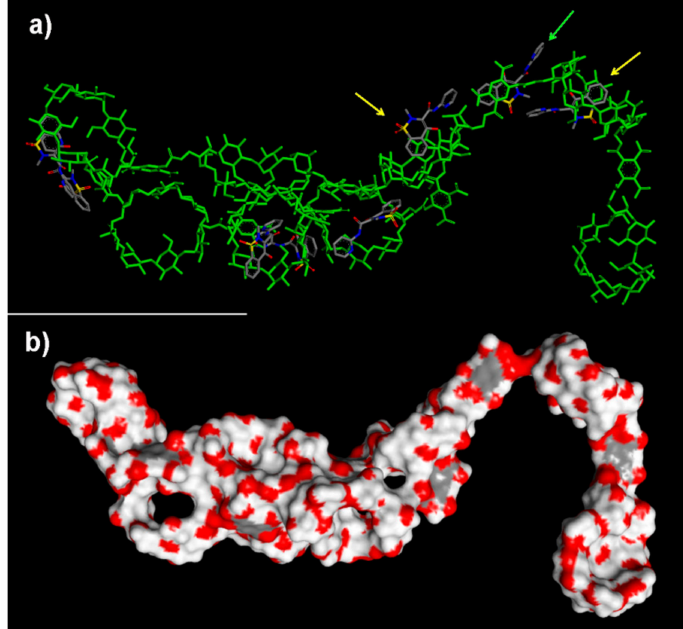
Figure 8. In the Figure, panel ( a ) shows the optimized geometry assumed by the NS / 8 PX drug molecules system at the end of the MD run displaying two types of interactions with hydrophobic cavities (see the yellow arrows) and six PX molecules interacting on the external surface of the NS. The NS is in green for clarity and the PX molecules are colored by atoms according to the color codes in Figure 3. Panel ( b ) shows the solvent-accessible surface area without the PX molecules for clarity (see the color codes in Figure